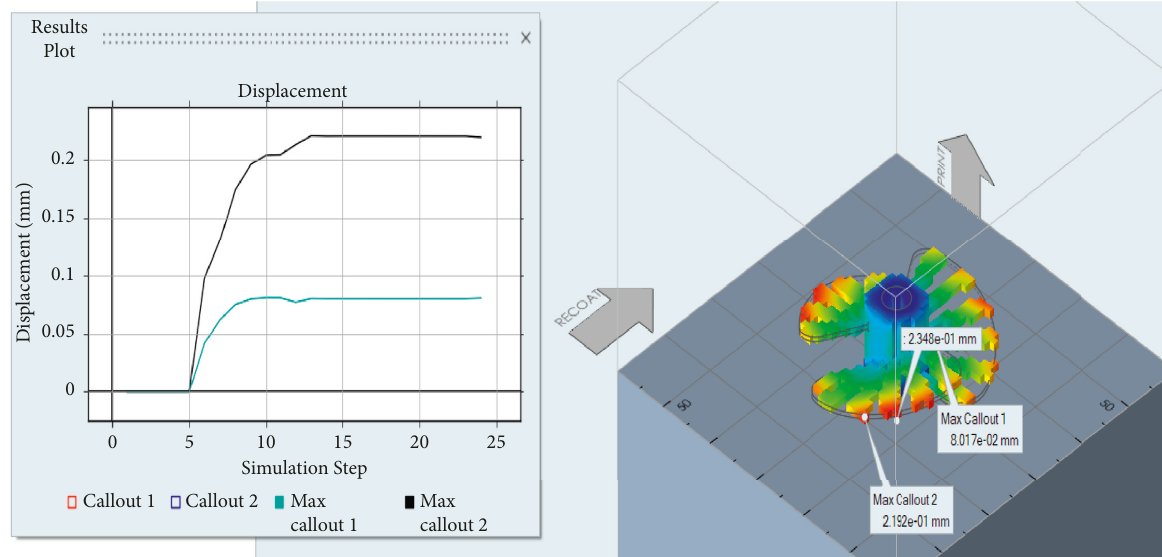
Figure 5: Displacement of various callout positions and a graph representing the displacement vs simulation step for Rank